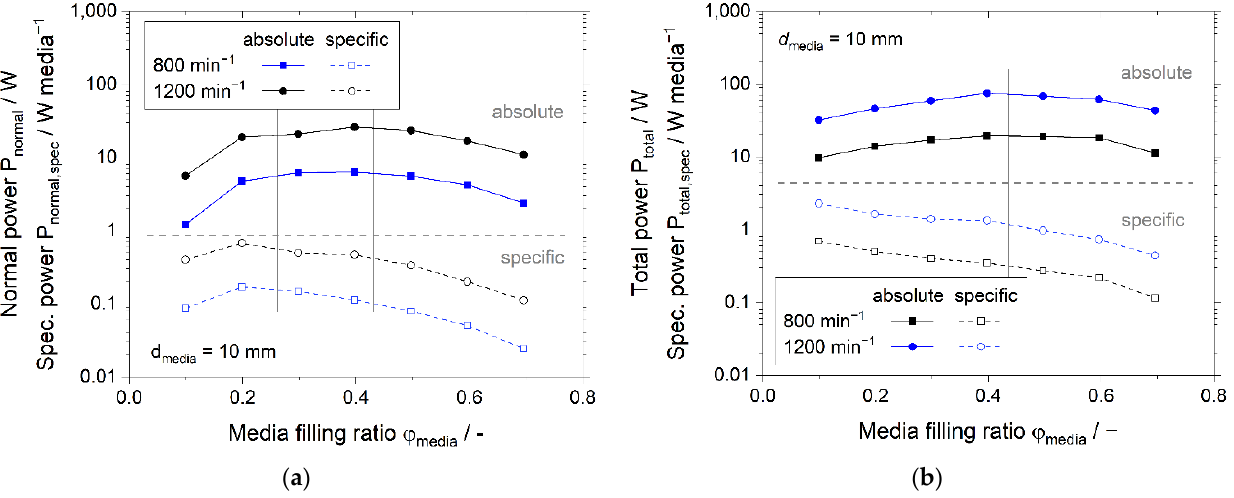
Figure 9. ( a ) Normal power and specific normal power (per media) in dependence on media filling ratio; ( b ) total power and specific total power (per media) in dependence on media filling ratio; d media = 10 mm, P spec = P (cid:2898) (cid:3171)(cid:3163)(cid:3162)(cid:3167)(cid:3159) N media